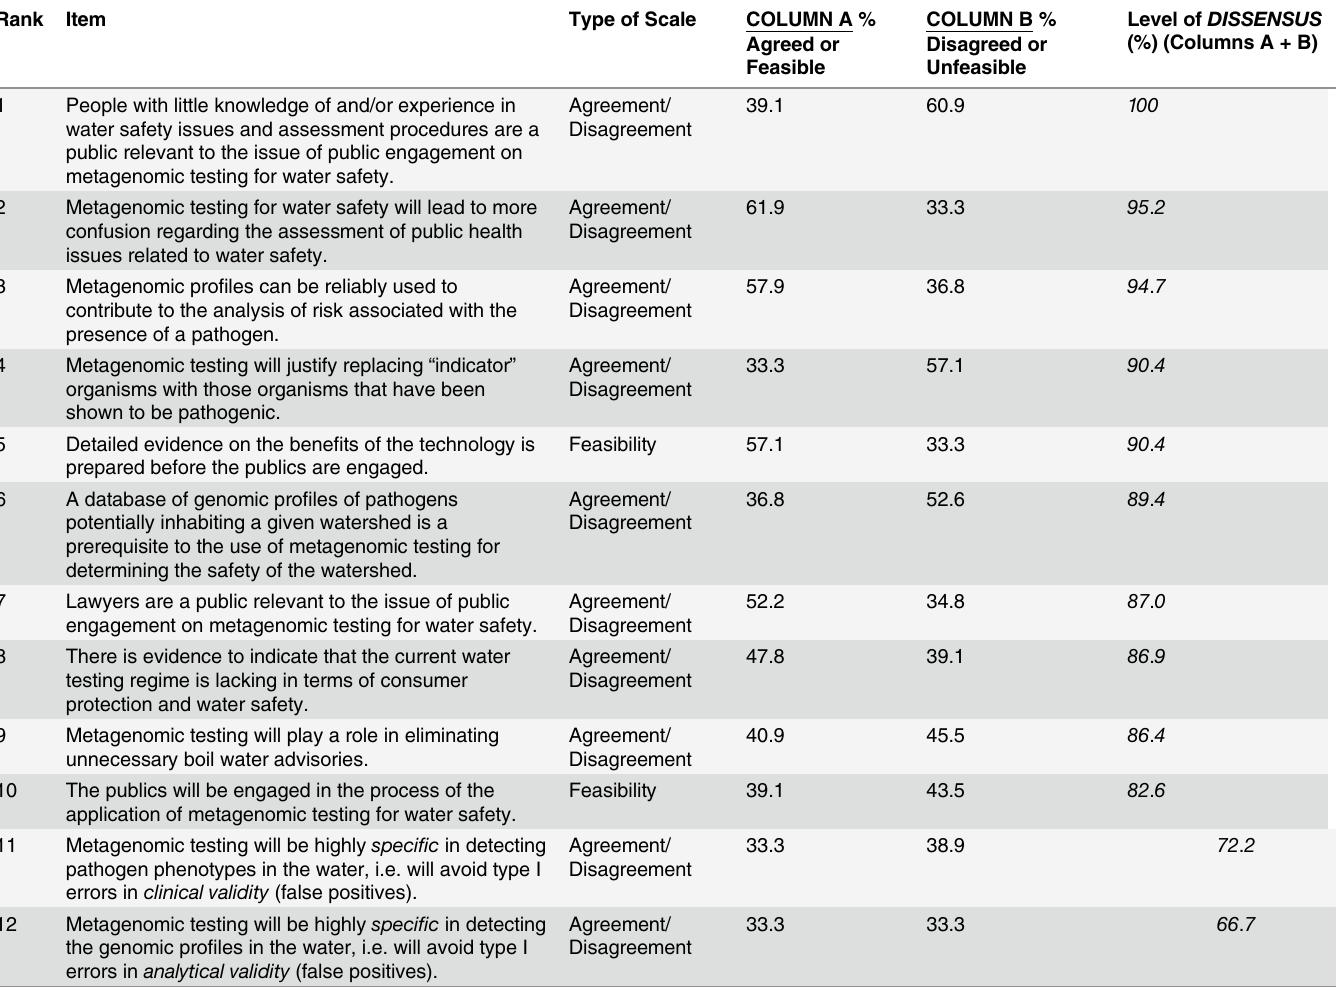
Table 5. Ranking of the Issues with DISSENSUS Among Experts in Regards to Metagenomic Tests for Water Safety. Rank